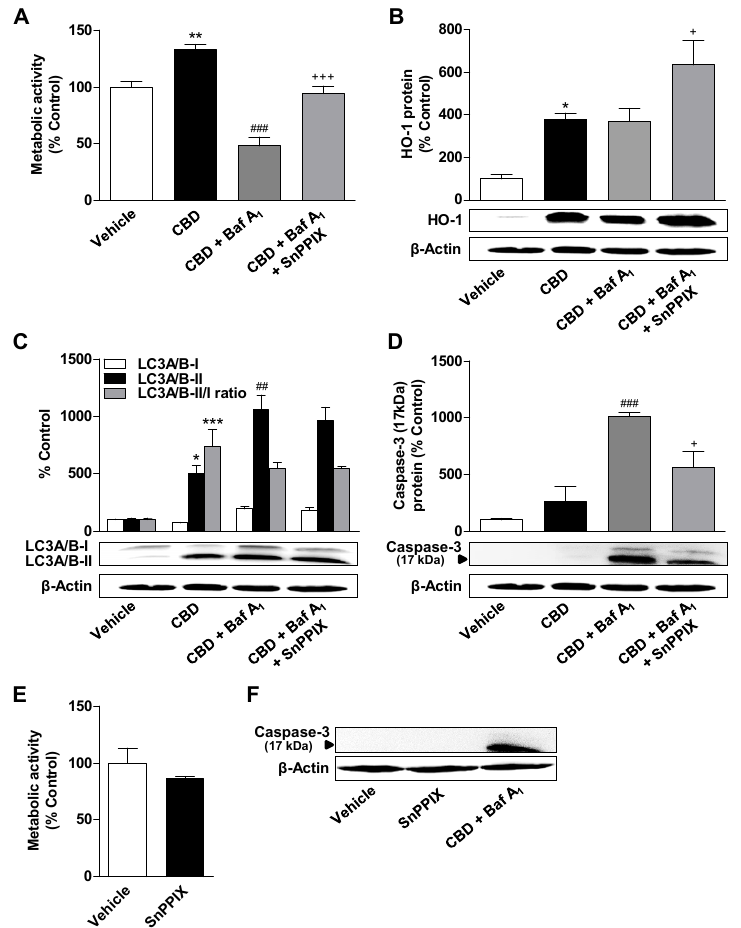
Figure 7. Effects of HO-1 inhibition on bafilomycin A 1 -induced changes in metabolic activity, HO-1 expression, autophagy, and apoptosis of CBD-treated ADMSCs. ADMSCs were pretreated for 30 min with the autophagy inhibitor bafilomycin A 1 (Baf A 1 ; 100 nM) and the HO-1 inhibitor SnPPIX (25 µM), and after subsequent addition of CBD (3 µM) or vehicle, the cells were co-incubated with the substances or vehicles for 24 h. Subsequently, the cells were analyzed for their metabolic activity ( A ), the expression of HO-1 ( B ) and LC3A/B-I/II ( C ), and the cleavage of caspase-3 ( D ). The effects of SnPPIX alone are shown in panel ( E ) for metabolic activity and in panel ( F ) for caspase-3 cleavage in the same experimental setting. The protein expression values were normalized to β -actin. The same actin blot was used as control in ( B , C ) and ( D ), since the proteins analyzed in these Western blots were resolved on the same gel. The percentage control provides a comparison with the vehicle-treated group (set to 100%). The data represent mean values ± SEM of n = 4 ( A – D ) and n = 6 ( E ) from different donors. * p < 0.05, ** p < 0.01, *** p < 0.001 vs. vehicle control; ## p < 0.01, ### p < 0.001 vs. CBD; + p < 0.05, +++ p < 0.001 vs. CBD + Baf A 1 ; one-way ANOVA with Bonferroni’s post hoc test.